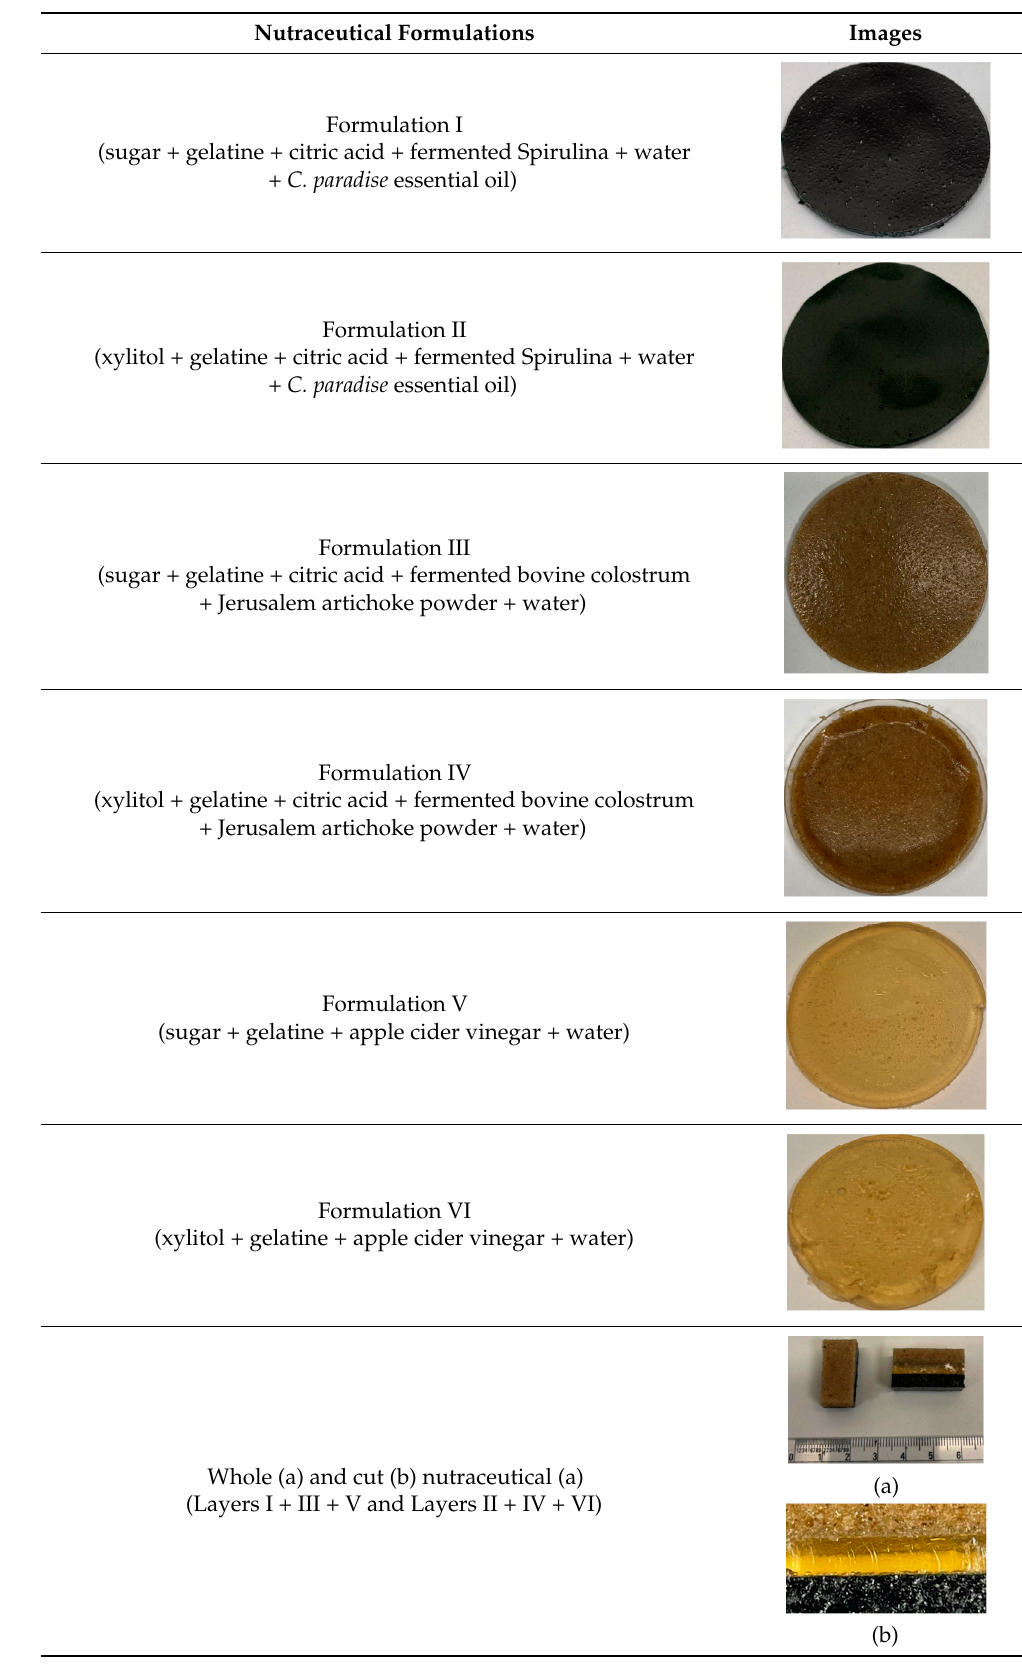
Table 2. Images of the separate nutraceutical layers and whole product.